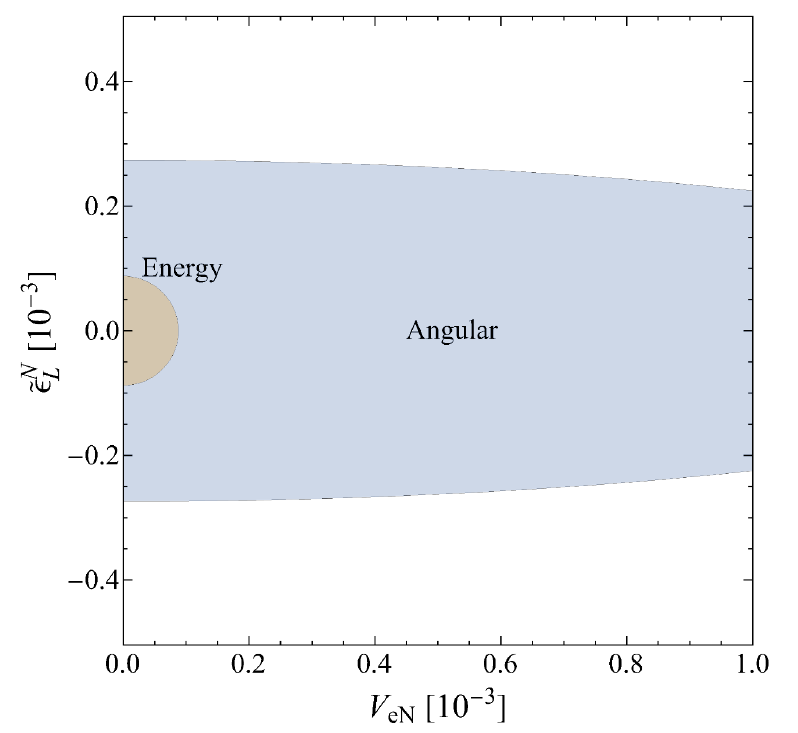
Figure 13 . Projected sensitivity at 95% CL on the active-sterile mixing V eN and the right-handed current of sterile neutrinos, ˜ (cid:15) N for m N = 10 keV and 10 18 events. The region derived from the L energy (angular) distribution is given in orange